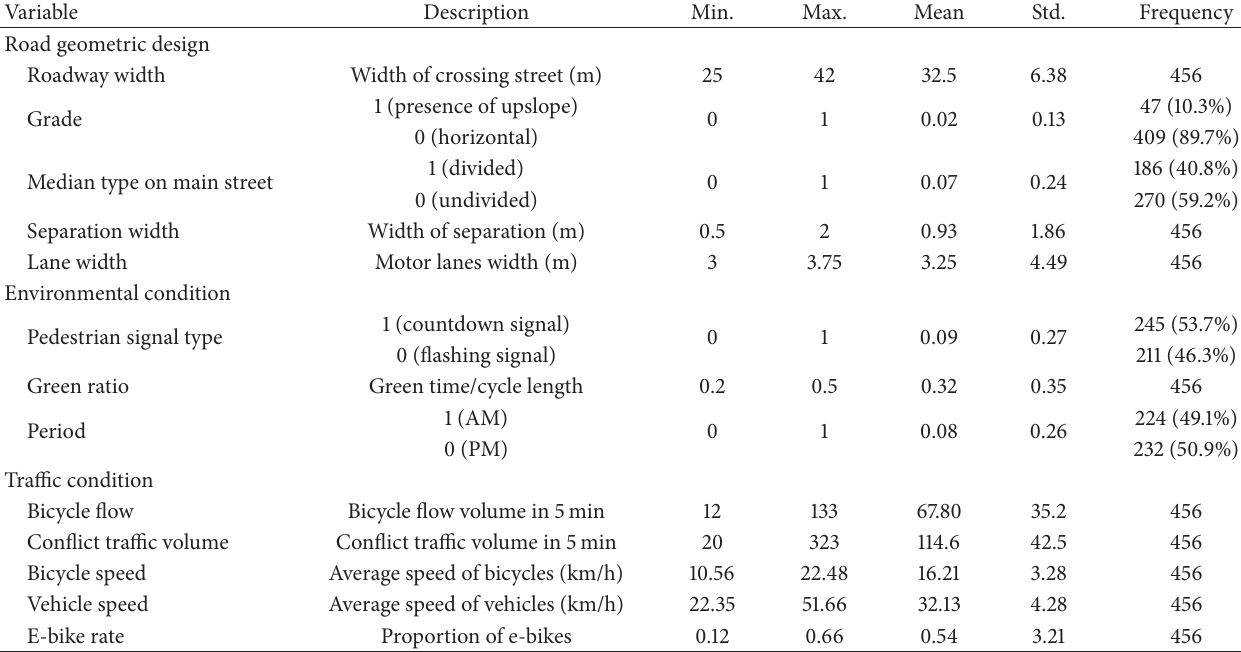
Table 1: Descriptive statistics of explanatory variables.